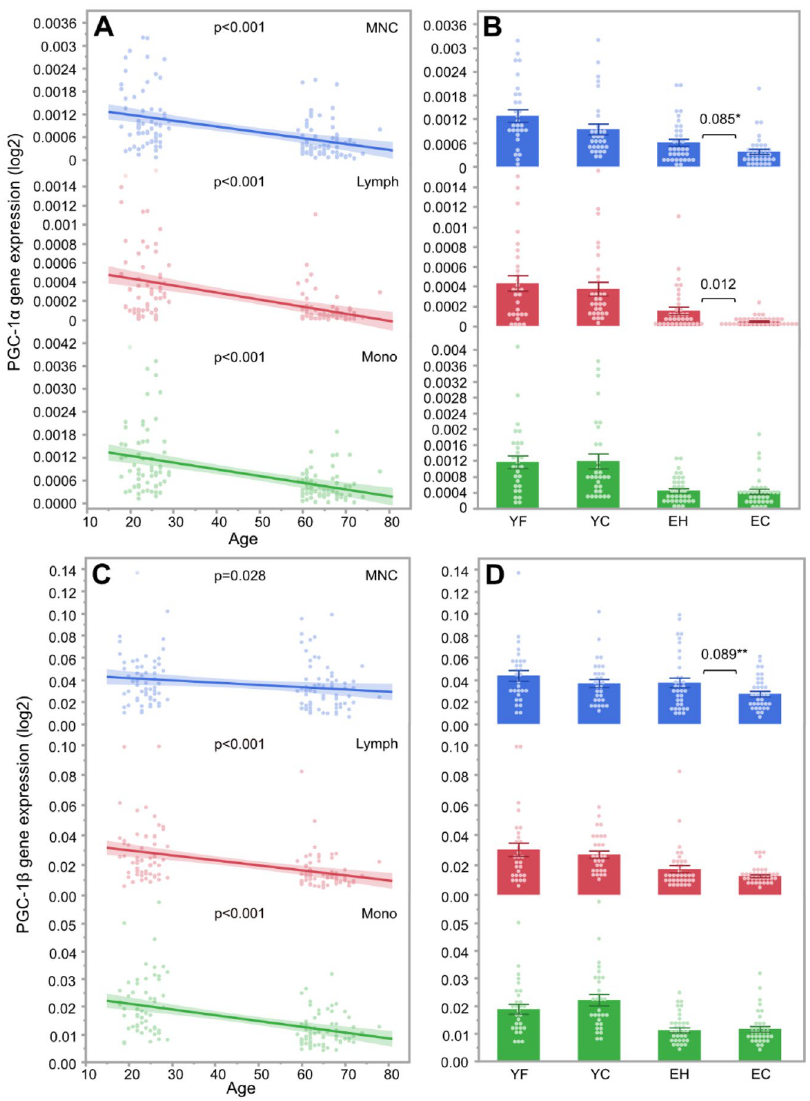
Figure 2. Correlation of PGC-1α gene expression with age (A) and group (B) as well as PGC-1β gene expression according to age (C) and group (D) in young football players (YF), young controls (YC), elderly team handball players (EH) and elderly controls (EC). Lymph lymphocytes; MNC mononuclear cells; Mono monocytes. *p = 0.041 in univariate analysis; **p = 0.044 in univariate